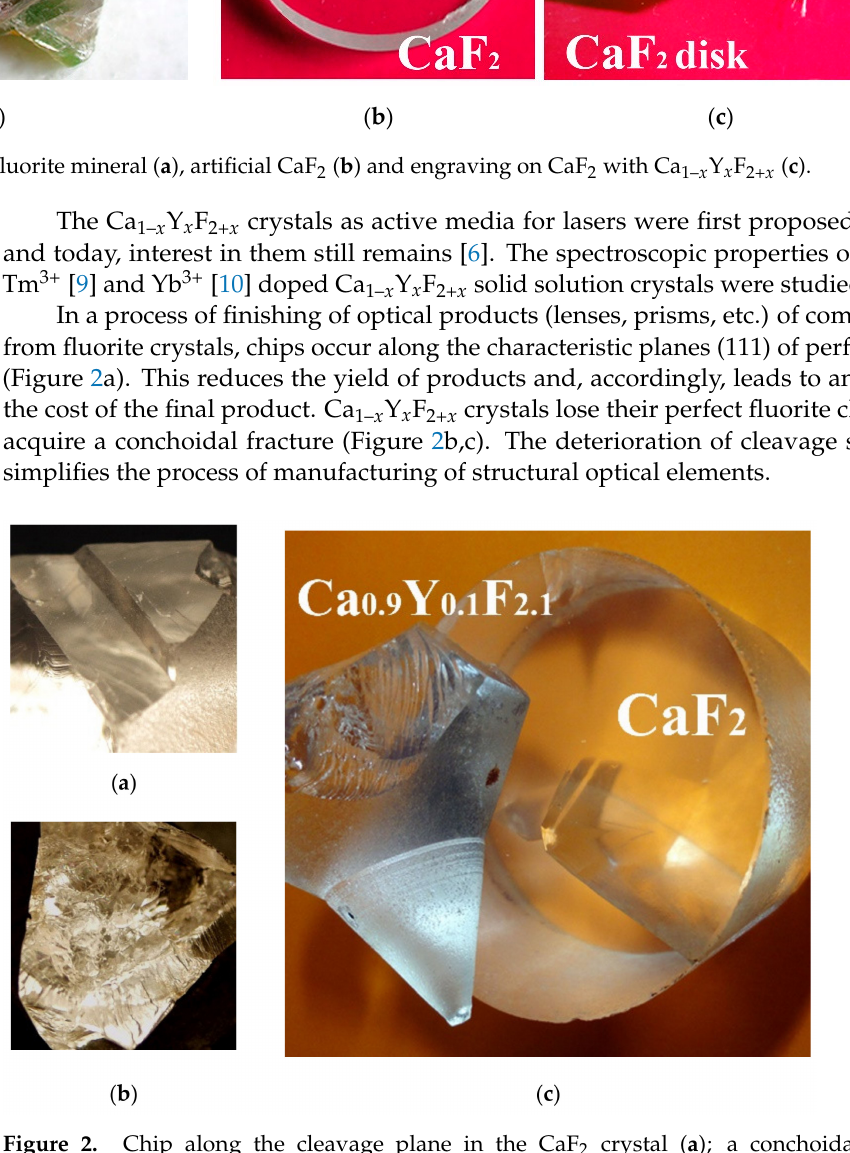
Figure 2. Chip along the cleavage plane in the CaF 2 crystal ( a ); a conchoidal fracture in Ca 0.9 Y 0.1 F 2.1 ( b ). A cleavage crack in CaF 2 and a conchoidal fracture in Ca 0.9 Y 0.1 F 2.1 (on the left) ( c